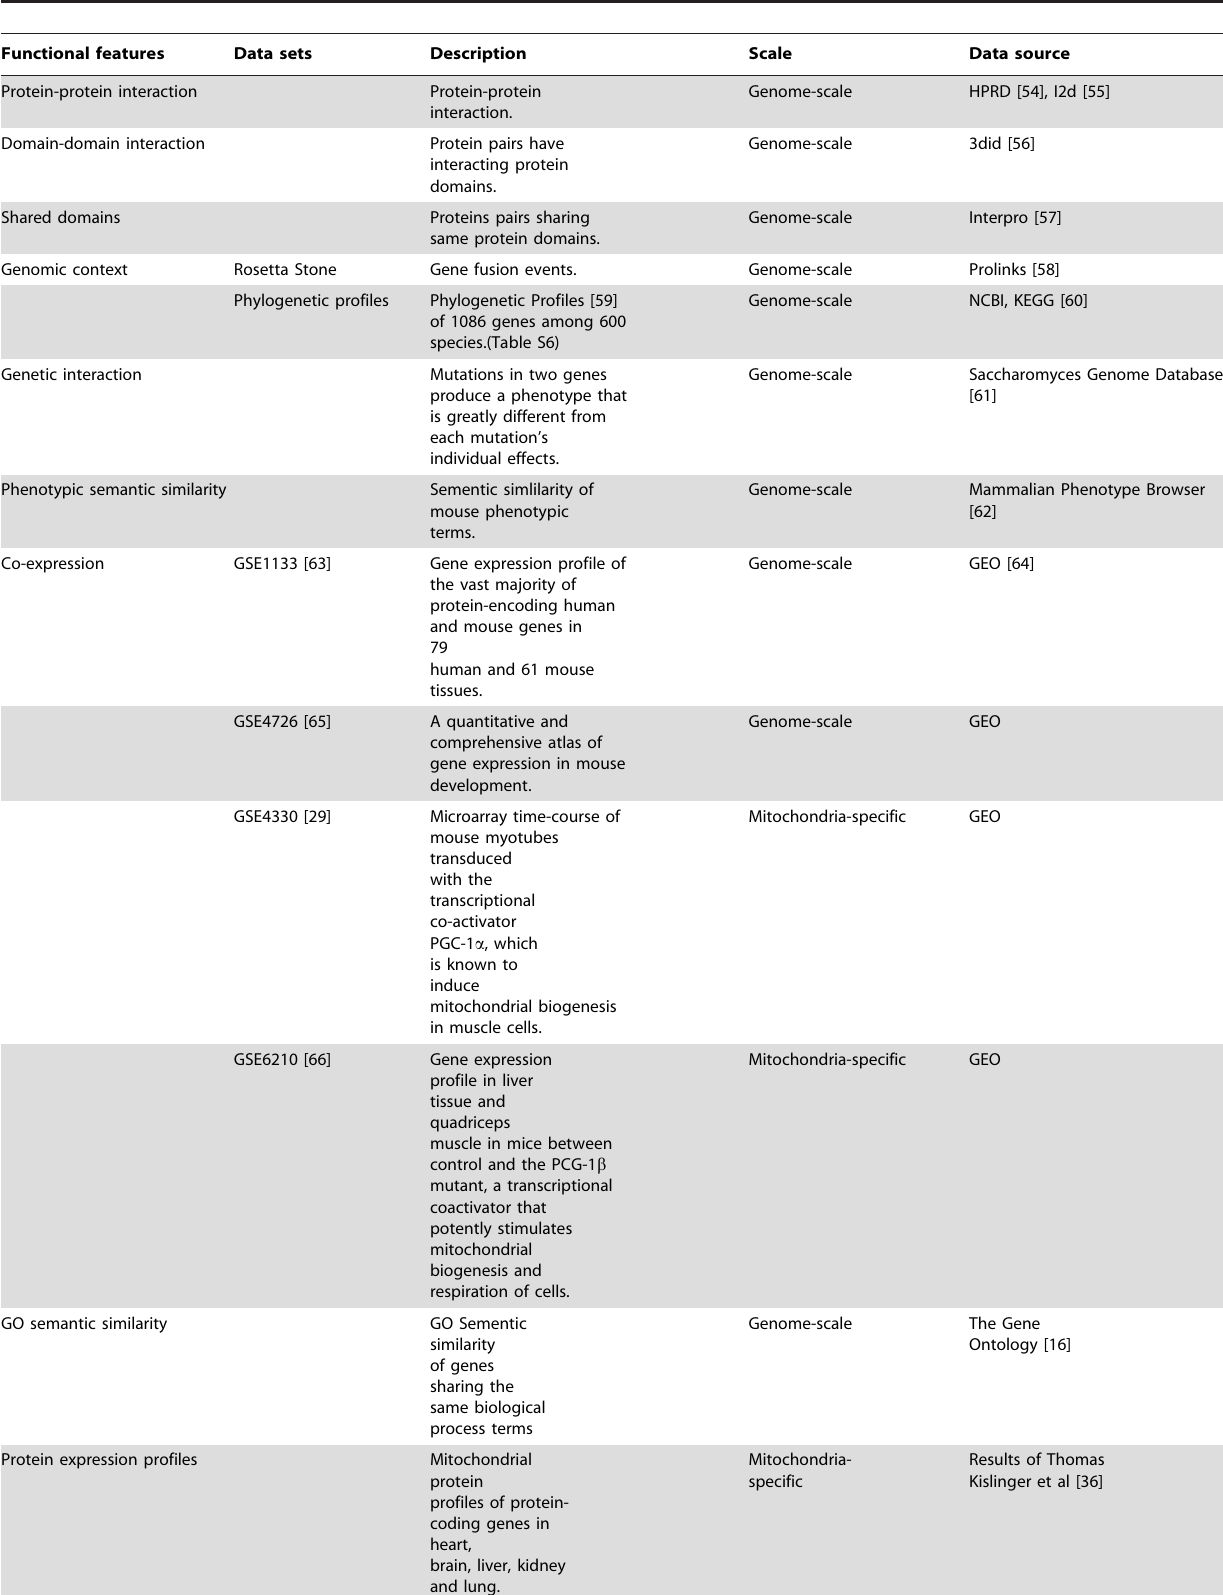
Table 3. Functional features for mammalian mitochondrial FLN